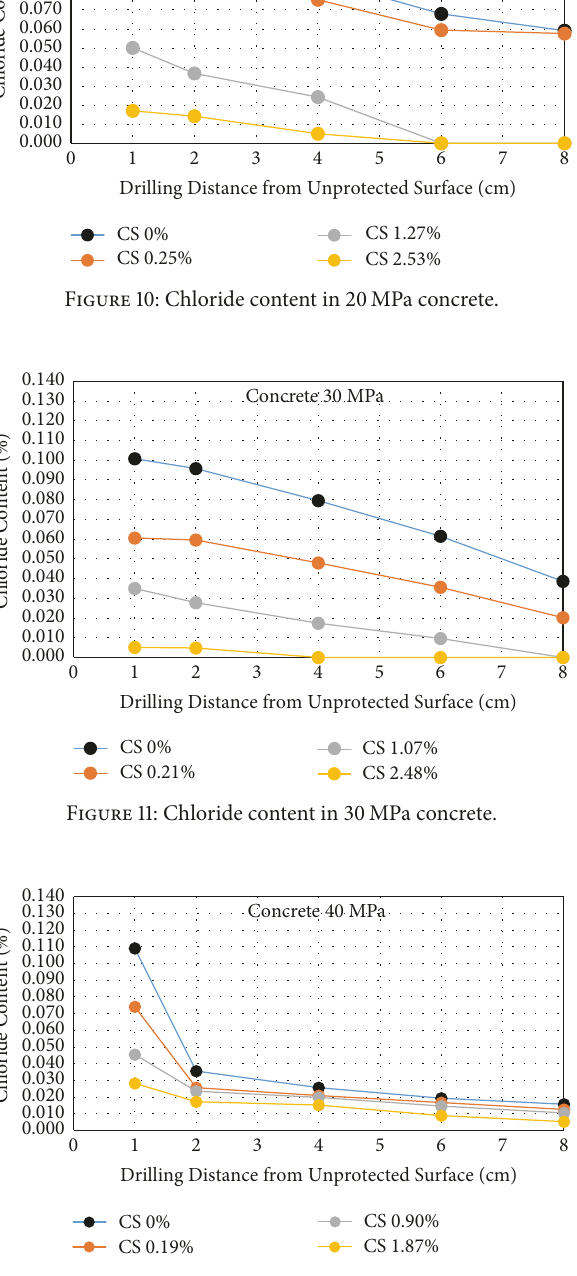
Figure 12: Chloride content in 40 MPa